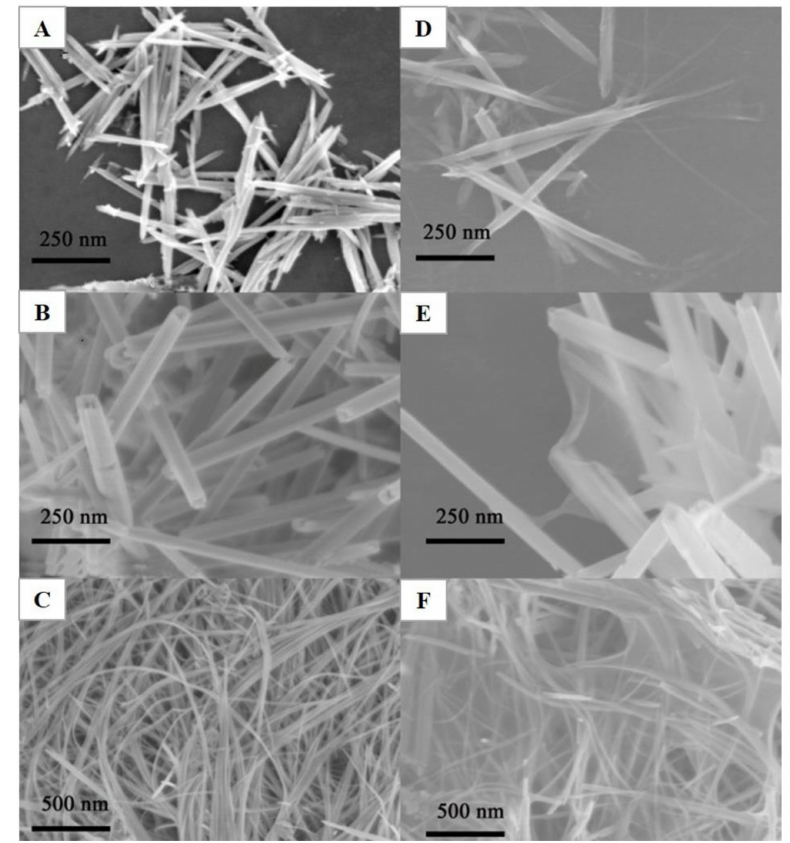
Figure 1. The scanning electron microscopy (SEM) images of MnO 2 nanomaterials and corresponding MnO 2 -reduced graphene oxide (RGO) nanocomposites. ( A ): MnO 2 nanorods (NRs); ( B ): MnO 2 nanotubes (NTs); ( C ): MnO 2 nanowires (NWs); ( D ): MnO 2 NRs/RGO; ( E ): MnO 2 NTs/RGO; ( F ): MnO 2 NWs/RGO.